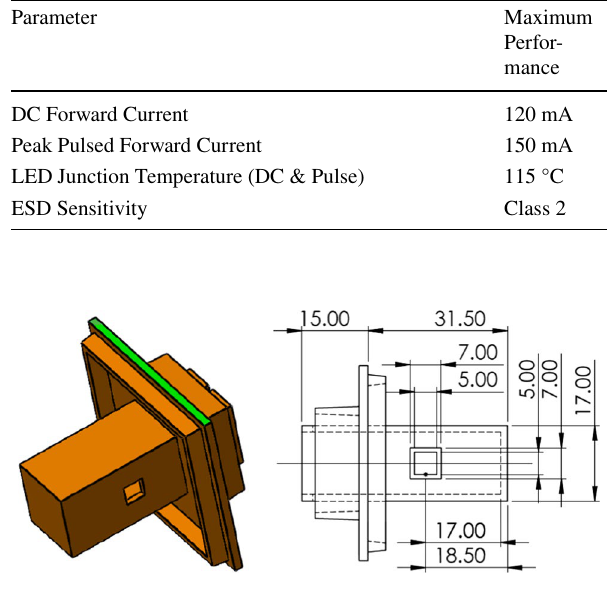
Fig. 4 Designed sensing chamber for handheld heavy metal detection system